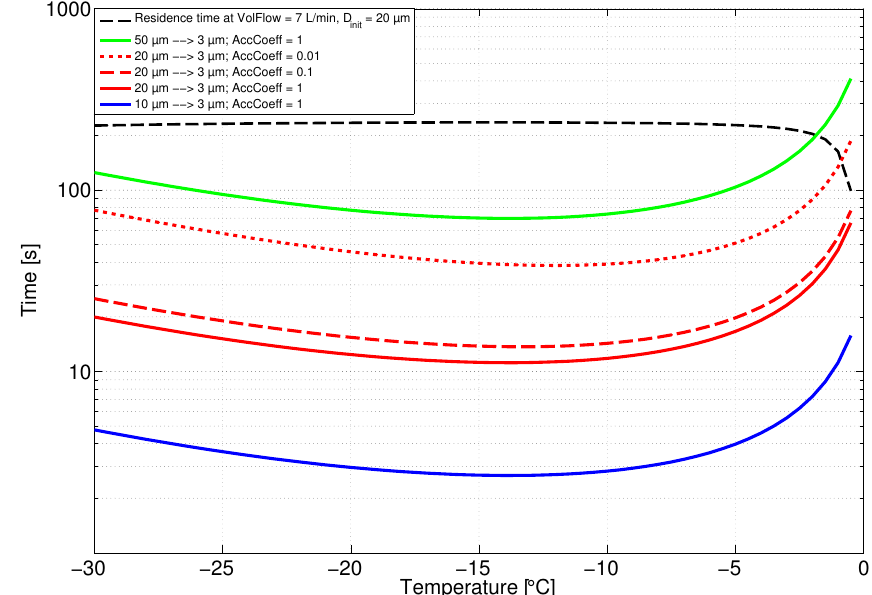
Figure 4. Evaporation times of cloud droplets for different droplet start and end diameters, and different mass accommodation coefficients, as a function of temperature at a pressure of p = 658 . 61hPa. The average residence time in the CLACE 2013 droplet evaporation unit as a function of temperature based on the dimensions of the droplet evaporation unit and a sample flow of 7Lmin − 1 is shown by the dashed black